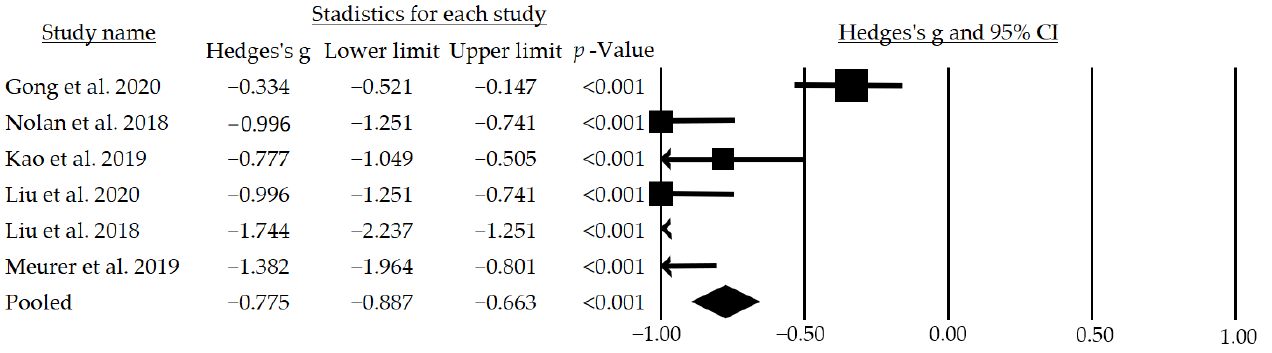
Figure 3. Effects of telemedicine on systolic blood pressure in people with hypertension. The black box represents the point estimate for the respective study, while the size of the box represents the population size and the horizontal line is the 95% CI. The diamond-shaped figure represents the estimated point of the mean effect size. The arrow represents that the point estimate for this study is less than − 1.00 [32–37].